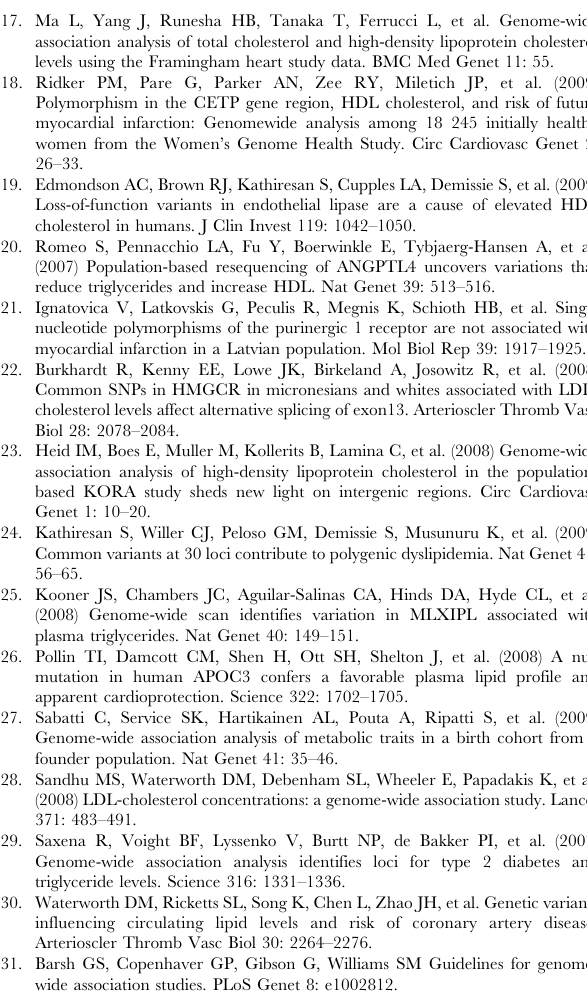
Figure S1 LD plot of genomic locus containing CETP gene. LD was determined considering all genotypes obtained in our study. Haploblocks identified using Haploview software v4.2 are shown by black lines, but different dotted lines represents haploblock boundaries calculated from HapMap